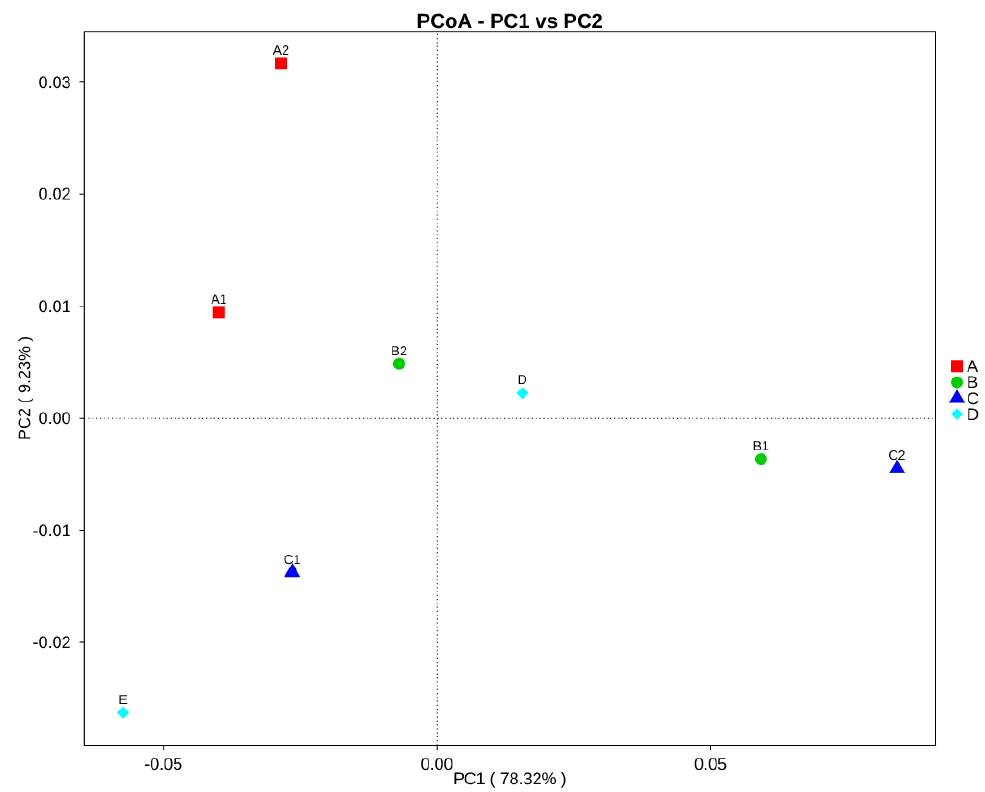
Figure 3. Principal coordinates analysis (PCoA) of the bacterial communities in honey from eight di ff erent stingless bee species. Principle coordinate analysis is based on the weighted Unifrac metric for bacterial communities. The red square represents stingless bee from Heterotrigona genus, the green dot represents Trigona genus, the blue triangle represents Tetrigona genus, meanwhile sample D and E represents separate genus which are Geniotrigona and Homotrigona, respectively.